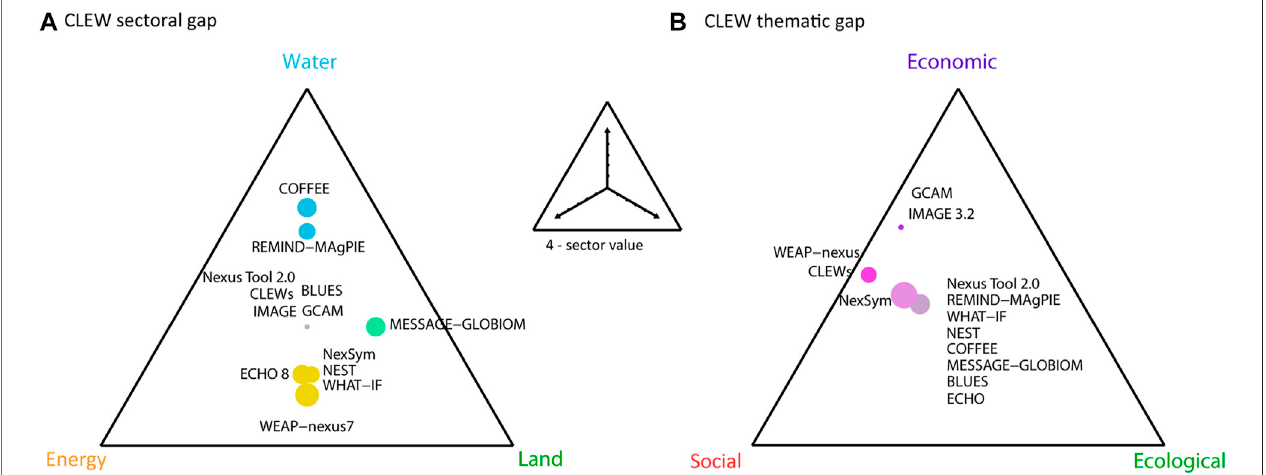
FIGURE3| Sectorgap,summaryofsimpli fi cationsofwater,energyandlandsystemscomparedtoadvancedsectoralmodels (A) .Thematicgap,simpli fi cationsor omission of possible social, economic and ecological aspects (B) . Size depending on the total gap considering CLEW sectors (The explanatory diagram in the center refers to sector value in Supplementary Tables S1, 2 ).